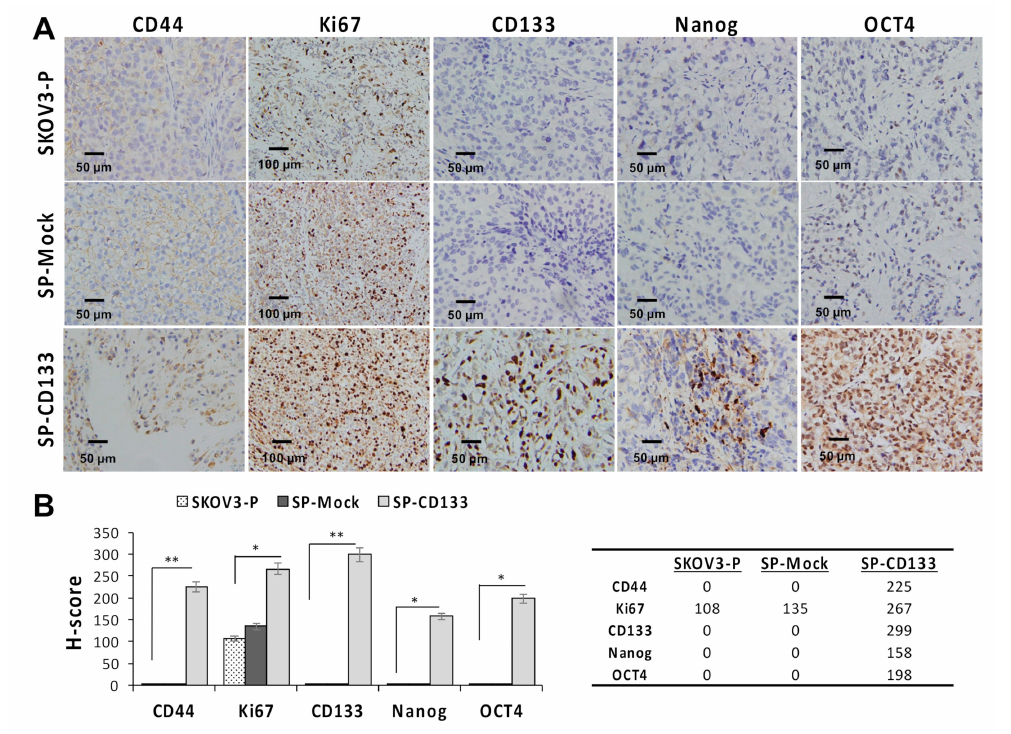
Figure 5. Cell proliferation and stemness related markers are overexpressed in SKOV3 spheres with cluster of di ff erentiation 133 (CD133) transduction (SP-CD133) tumors. Tumors were harvested from mice bearing SP-CD133, SKOV3 spheres with mock-transduction (SP-Mock), and parental SKOV3 (SKOV3-P) subcutaneous (s.c.) xenografts. ( A ) Formalin-fixed, para ffi n-embedded tumor sections were consecutively cut and stained for human CD44, Ki67, CD133, Nanog, and Oct4. Images were taken using a camera (DP22) and microscope (BX50) under 400 × or 200 × magnification. Individual scale bars are shown. ( B ) An average H-scores for each marker and comparison between groups are shown (* p < 0.05; ** p <